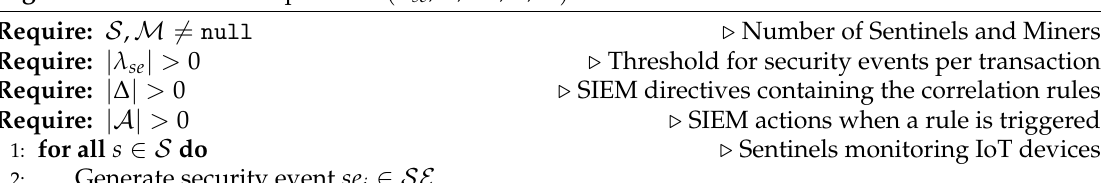
Algorithm 1 Scenario 2 Experiment ( λ se , S , M , ∆ , A )